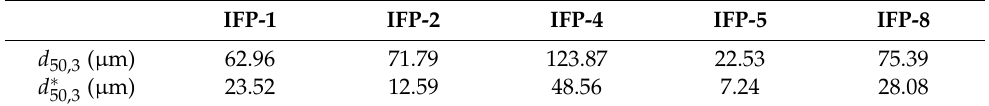
Figure A1. Classification of hysteresis exhibiting isotherms according to IUPAC [19,32]. The right-facing arrow indicates the adsorption branch and the left-facing arrow indicates the desorption branch. Table A1. Volumetric median diameters of the IFP samples before and after agglomerate breakage (*).